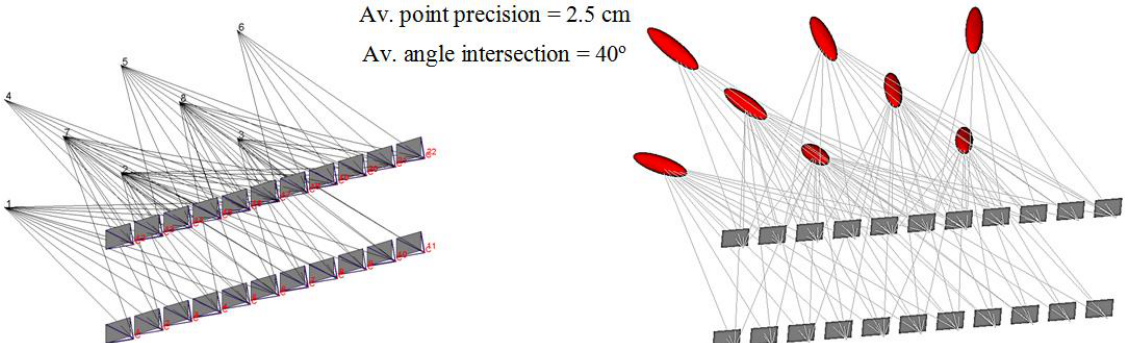
Figure 8. The simulated dense camera network for the verification test and the magnitude of imaging coverage and error before filtering.